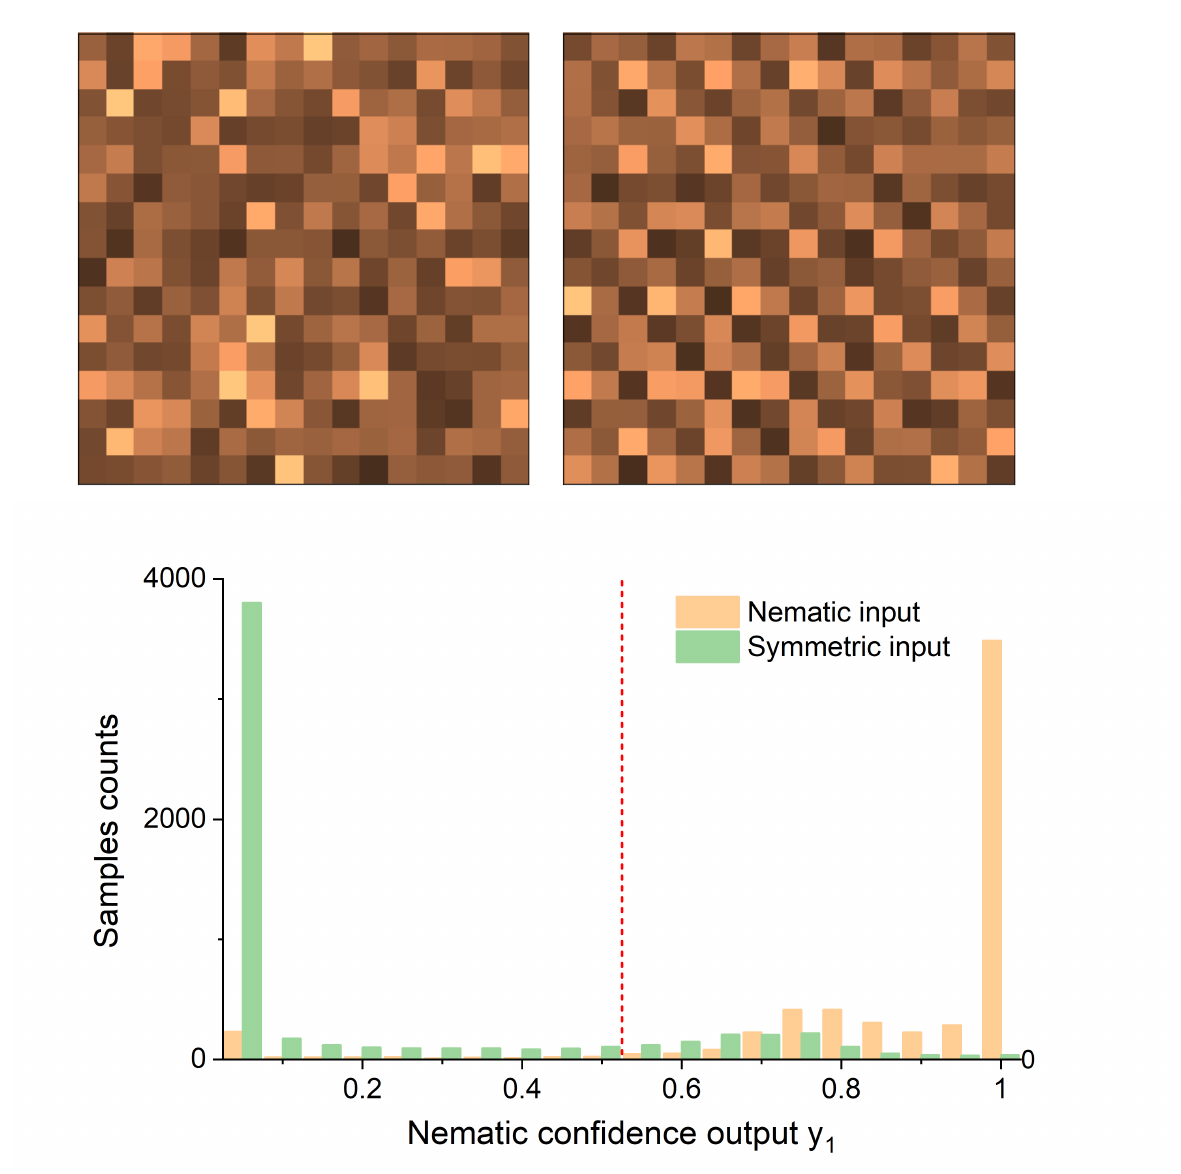
Figure 2: (Left) A simulated LDOS N ( r ) image for the nematic phase, and (right) a simulated LDOS N ( r ) image for the symmetric phase. The finalized ANN with a single hidden layer correctly identifies the classification with over 95% confidence for both images. While we may observe elusive traces of anisotropy between the two images with our naked eyes, the signatures are nevertheless hard to summarize and quantify for a clear-cut detection. (Bottom) the distribution of the neuron output y 1 among 5940 nematic sample images and 5940 symmetric sample images. The ANN = 1 − y confidence of the symmetric phase y . For most of the sample images, the 2 1 ANN is able to distinguish the correct phase with high